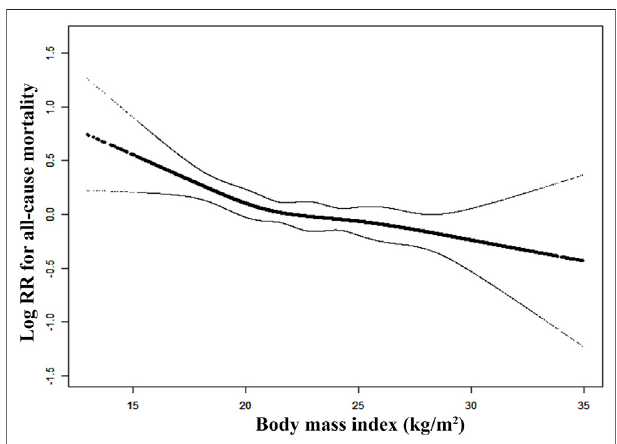
FIGURE 2 | Smooth curve of correlation between body mass index level and all-cause mortality. Note: Smooth curve adjusted for age, sex, current smokers and drinkers, SBP and